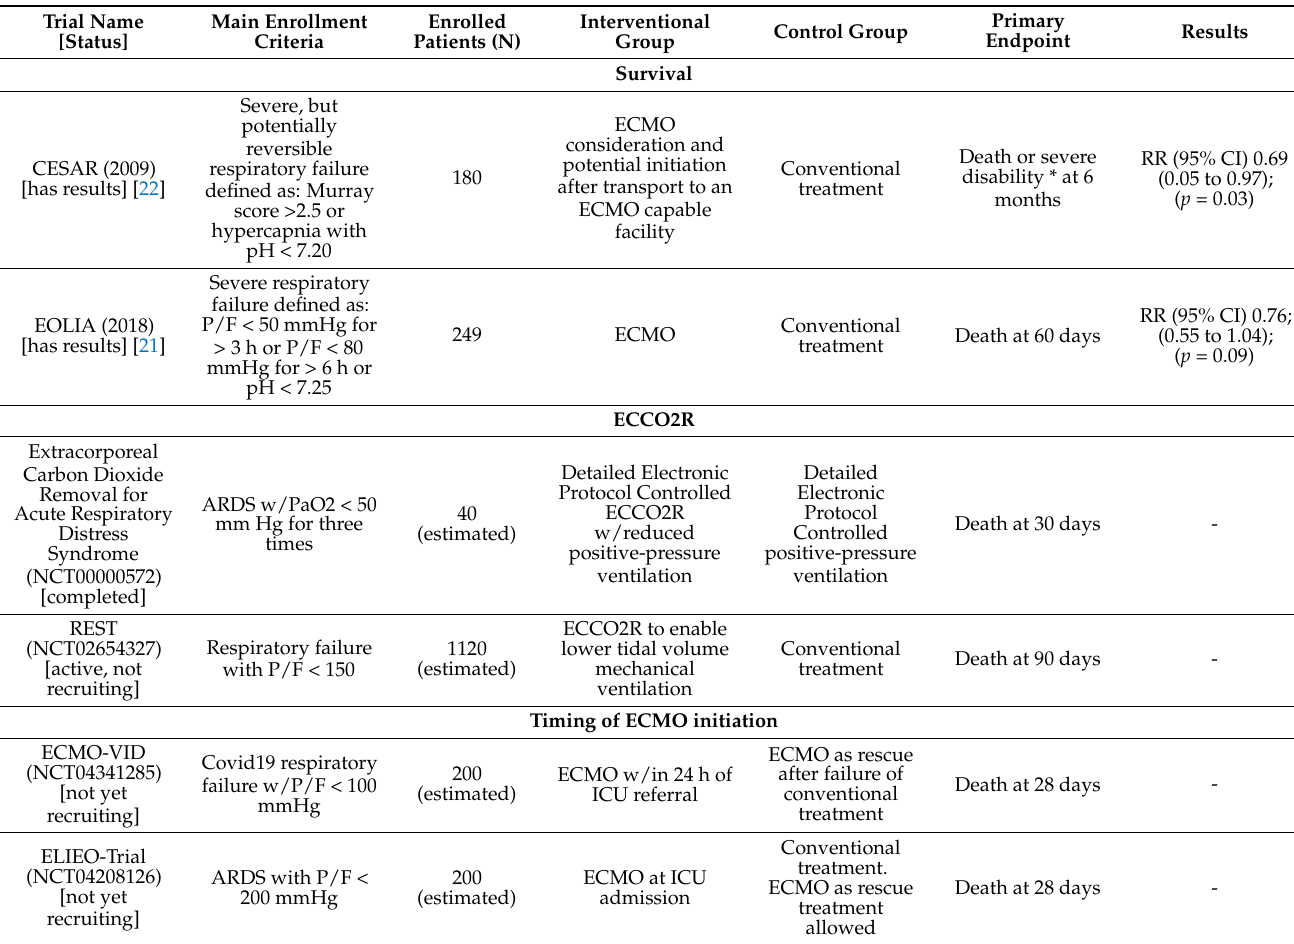
Table 1. Published and ongoing randomized controlled trials on VV-ECMO in ARDS patients. Trials are grouped by the research question they